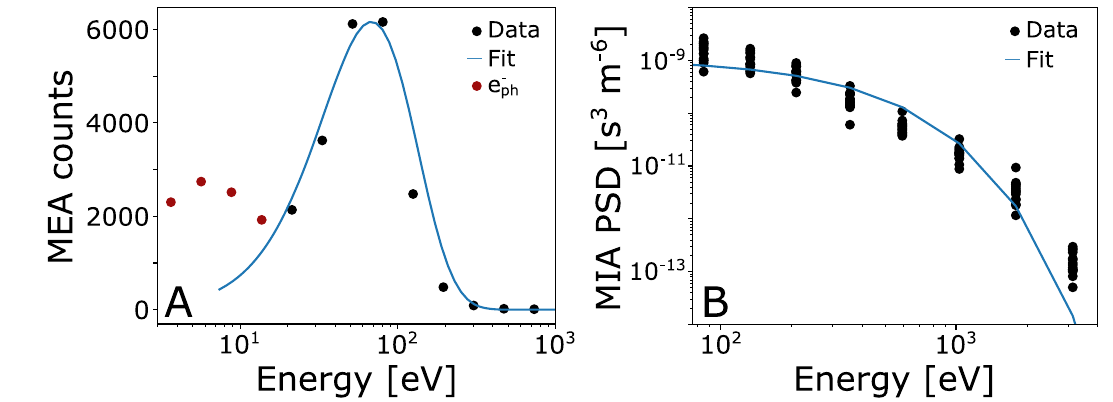
Fig. 7 | Temperature calculations from fi tting to the measured energy dis- tributions of ions and electrons. Maxwellian distribution fi ts to ( A ) electron counts measured by MEA and ( B ) proton phase space density (PSD) measured by MIA. The black dots show the measurement and the blue line shows the fi tted distribution. The electron distribution was measured at 13:57 UT, and the 15 ion distributionsused forthe fi tweremeasuredbetween13:57and 13:58UT.The fi tted